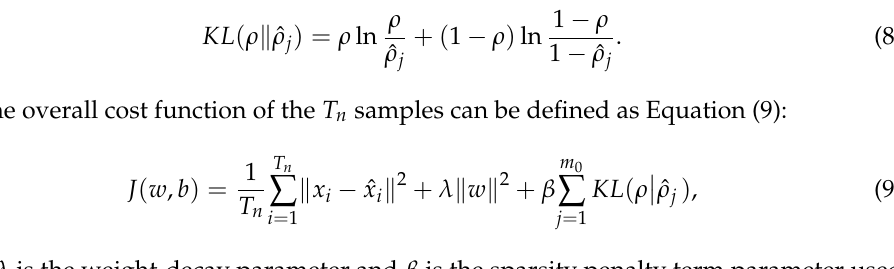
and is equal to the γ calculated in Section 3.2.1